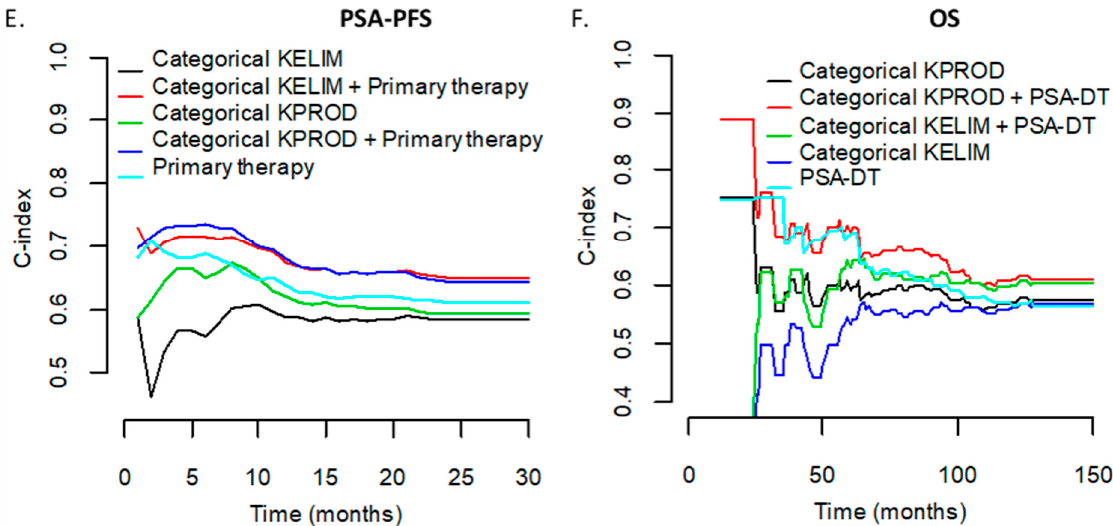
Figure 4. Univariate analyses (Kaplan–Meier) and multivariate concordance index (C-index) analyses. PSA-PFS ( A ) and OS ( B ) Kaplan–Meier curve according to categorical KELIM. PSA-PFS ( C ) and OS ( D ) Kaplan–Meier curve according to categorical KPROD. C-index as a function of the time for PSA-PFS ( E ) and OS ( F ) comparing different Cox regression models. Table 1. Kaplan–Meier and Cox regression results. Kaplan–Meier results (median time in months) for categorical KELIM and KPROD. NR: Not reached. CI: Confidence interval. Cox regression results for categorical KELIM and KPROD. HR: Hazard Ratio. CI: Confidence Interval. PSA-DT: PSA doubling